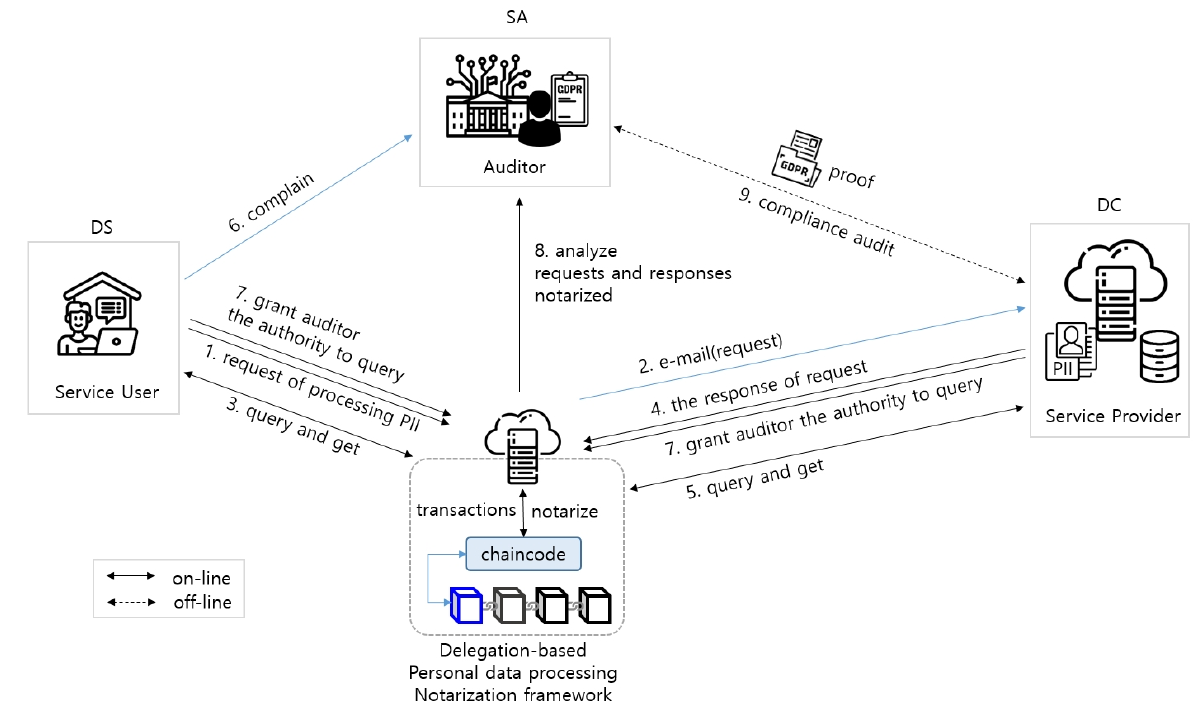
Figure 1. A procedural overview of the personal data processing request notarization framework.